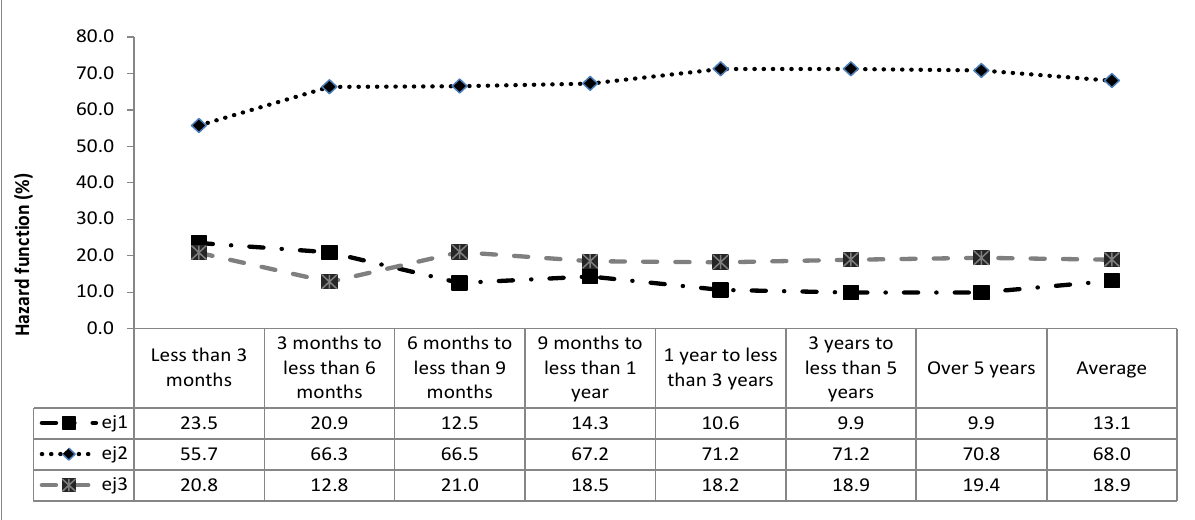
figure 1: Hazard functions for the different unemployment